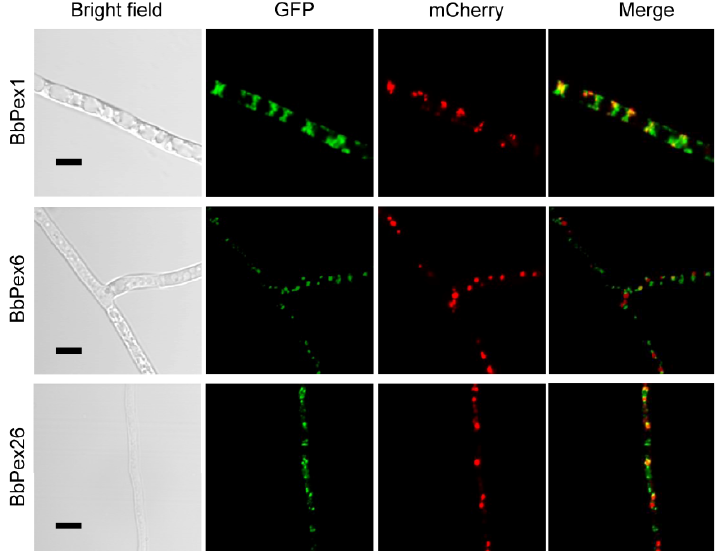
Figure 1. Subcellular analyses of three peroxins in B. bassiana . The coding sequence of the indicated peroxin was fused to the green fluorescent protein gene ( GFP ), and peroxisomal targeting signal sequences were fused to mCherry gene. Two resultant hybrid genes were transformed into the wild-type strain. Mycelia were cultured in SDB medium, and fluorescent signals were examined under a laser scanning confocal microscope. Scale bars: 5 µ